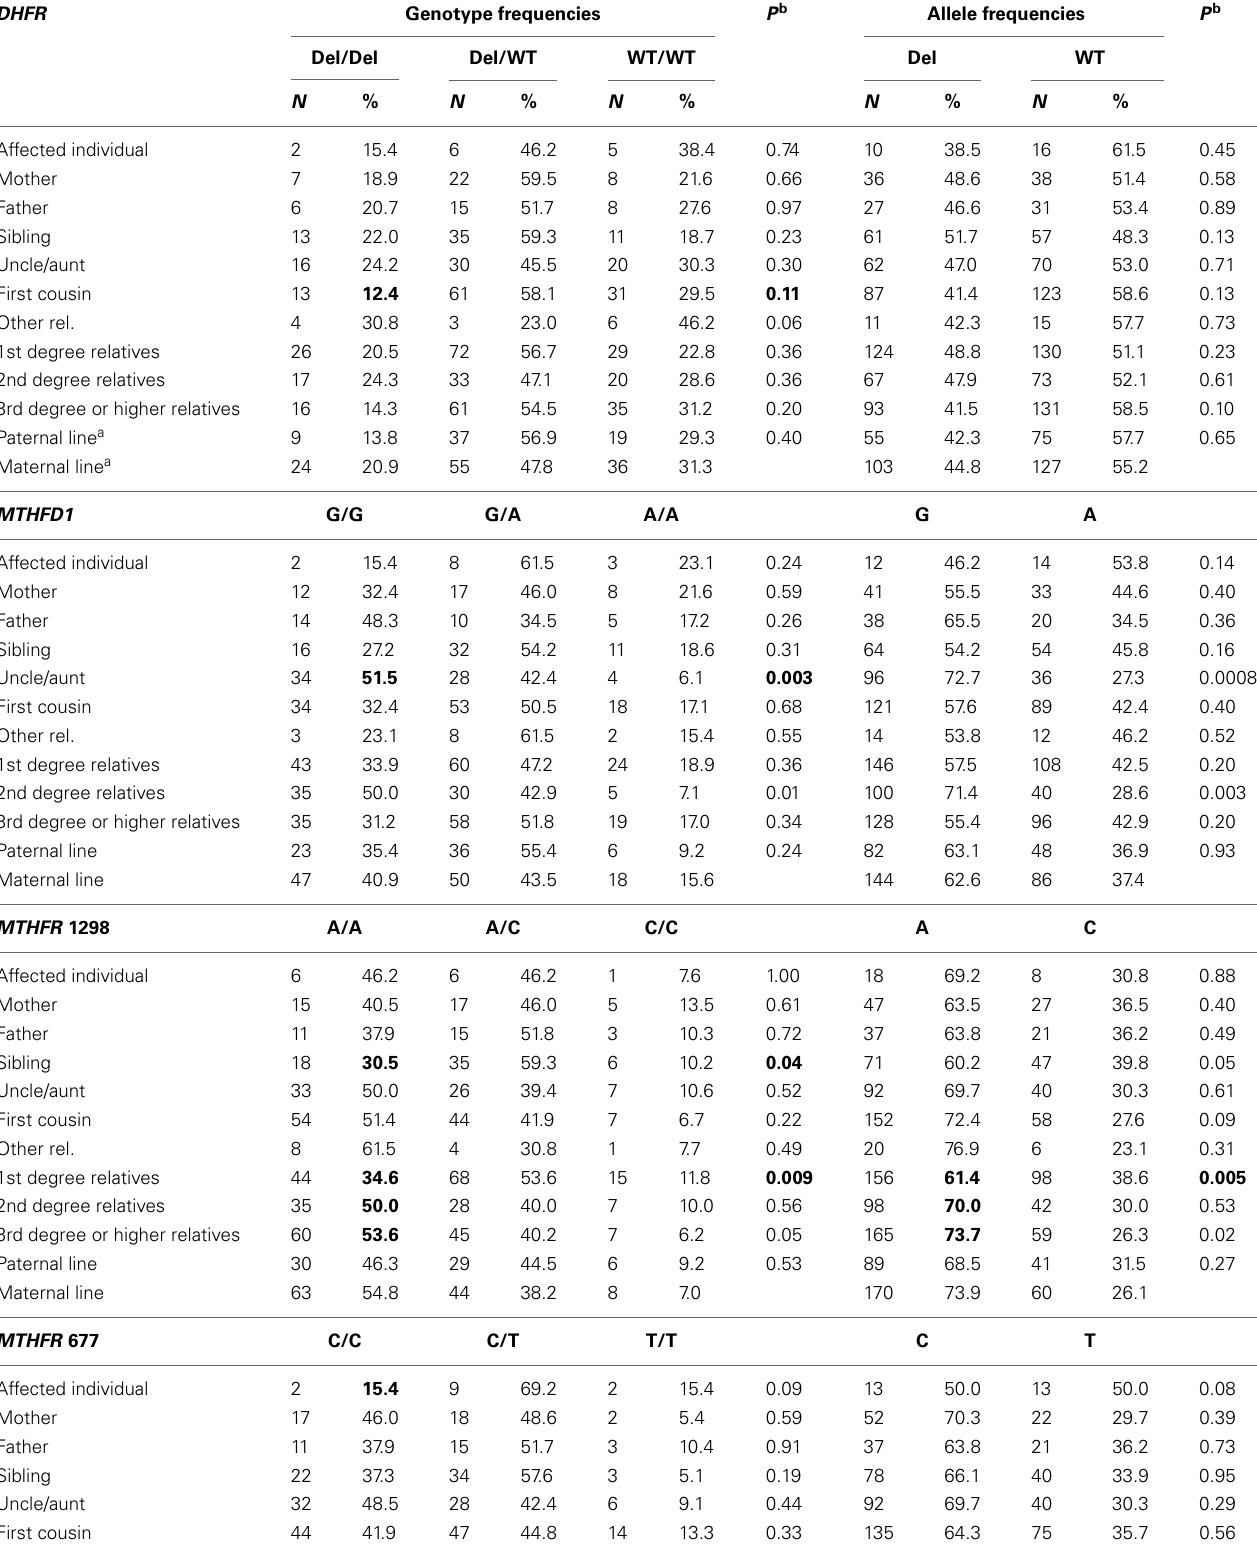
Table 4 | Distribution of genotypes and alleles according to relationship within NTD-affected families and lineage, northeast region of the Republic of Ireland and Northern Ireland,